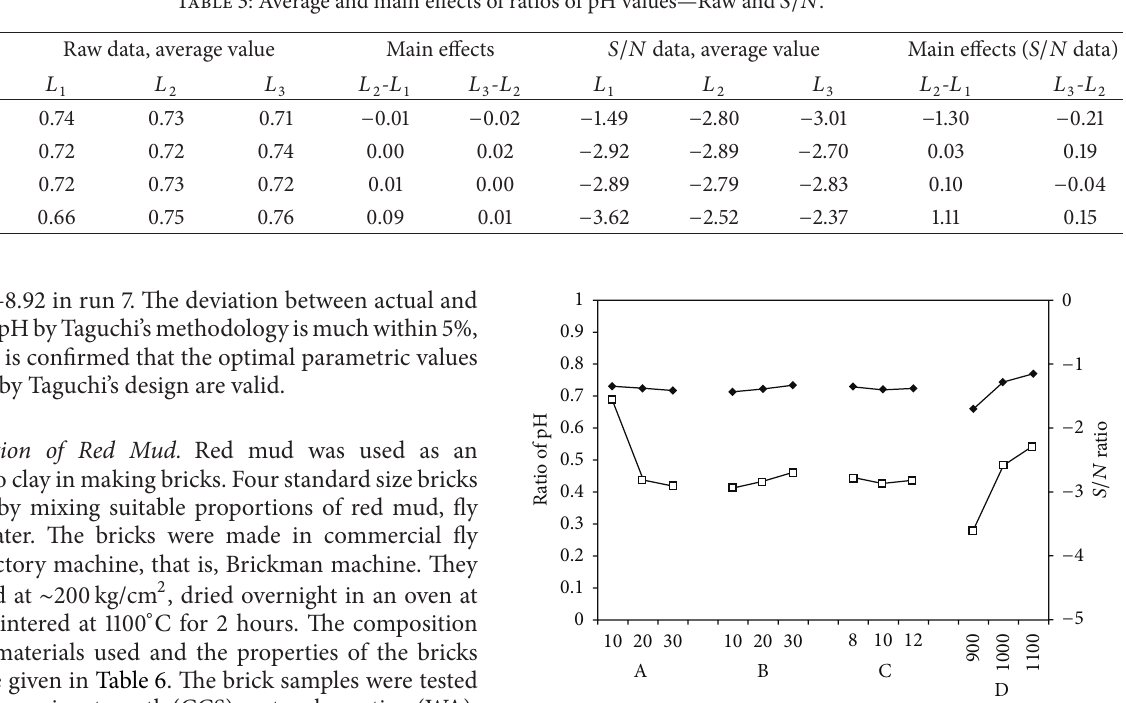
Table 3: Average and main effects of ratios of pH values—Raw and 𝑆/𝑁 .